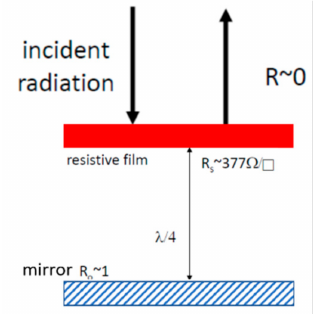
Figure A1. Ideal optical cavity based on Salisbury